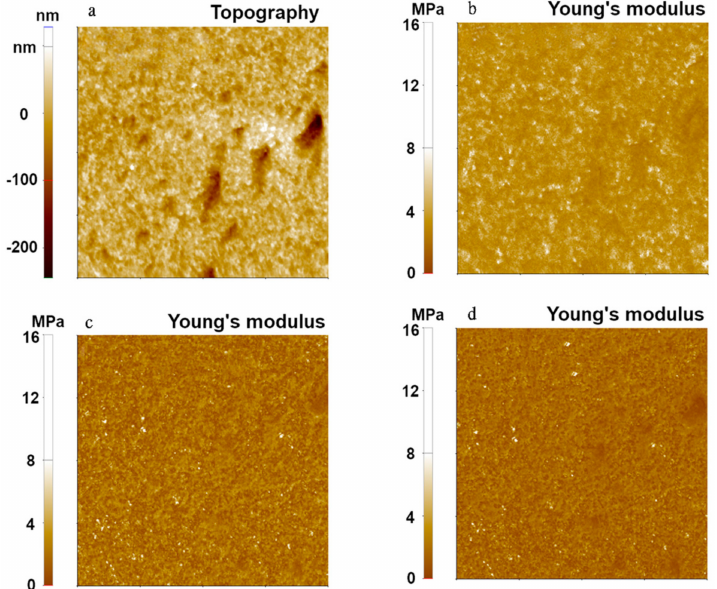
Figure 2. Surface topography ( a ) and Young’s modulus images ( b – d ) of PDMS using the PinPoint TM nanomechanical mode. The Young’s modulus was calculated using the Hertzian model ( b ), the DMT model ( c ), and the JKR model ( d ). The scan size of all images was 10 µ m × 10 µ